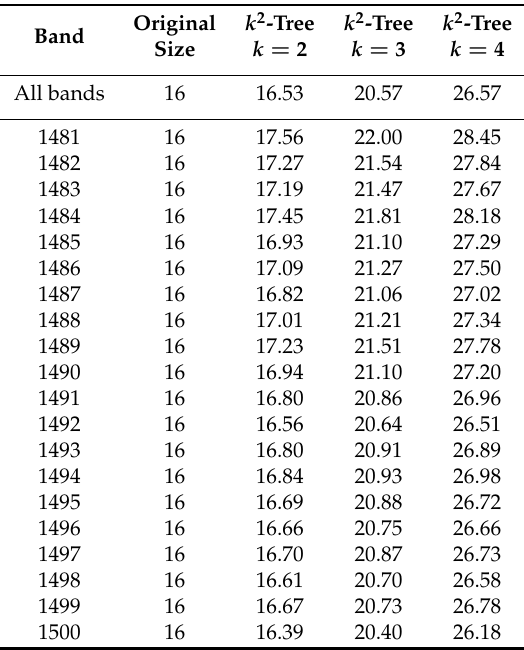
Table 12. The sizes of AIRS Granule (AG9) produced by 3D to 2D mapping from k = 2 to k = 4. The individual band sizes ranging from 1481 to 1500 are also shown. Sizes for individual bands are in bits per pixel (bpp), while the ones for all bands are in bits per pixel per band (bpppb).